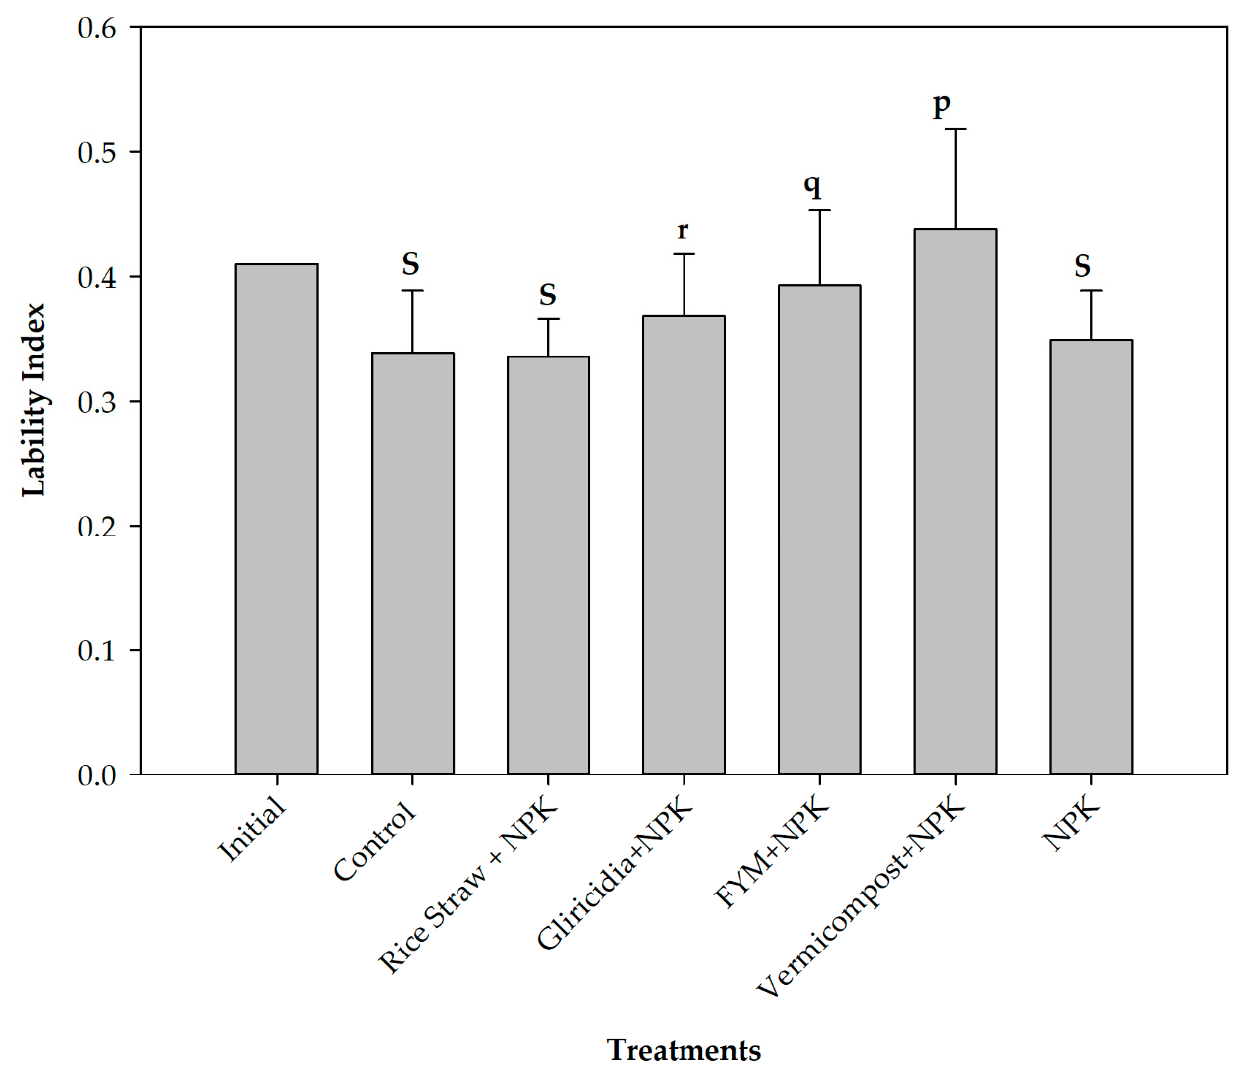
Figure 4. Effects of treatments on the lability index (LI). The values are the averages and error bars are the standard deviations of measurements over three crop growth stages through three consecutive crop growing seasons. Bars followed by the same letter are not significantly different at p < 0.05.